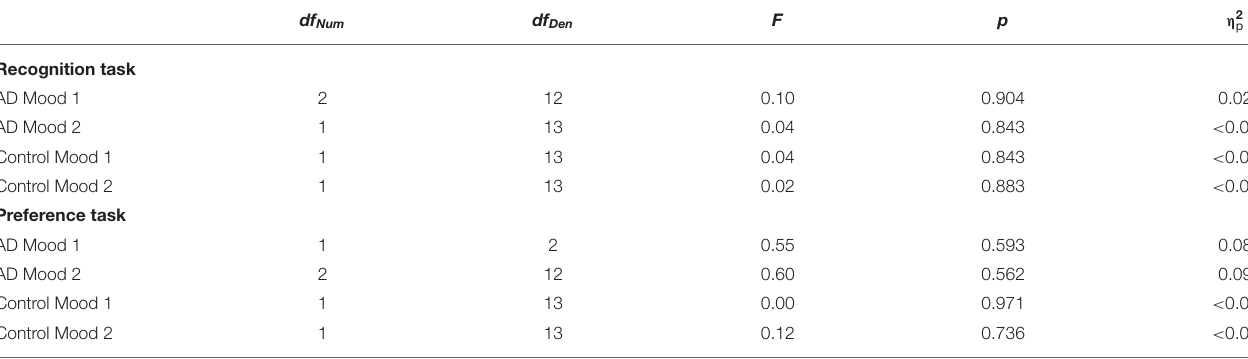
TABLE 6 | Effects of mood on recognition and preference